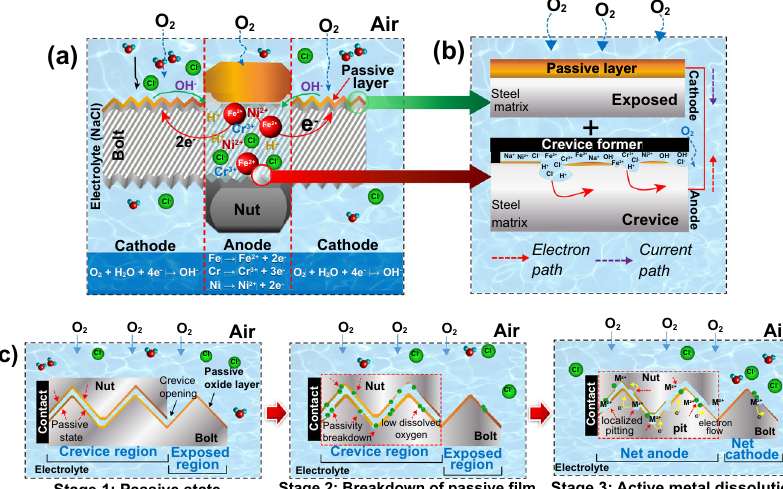
Fig. 9 Schematic illustration of the proposed mechanism of corrosion in 304 stainless steel fasteners. a Coupled condition, b isolated condition and c time-dependent evolution of the 304SS fastener corrosion process.